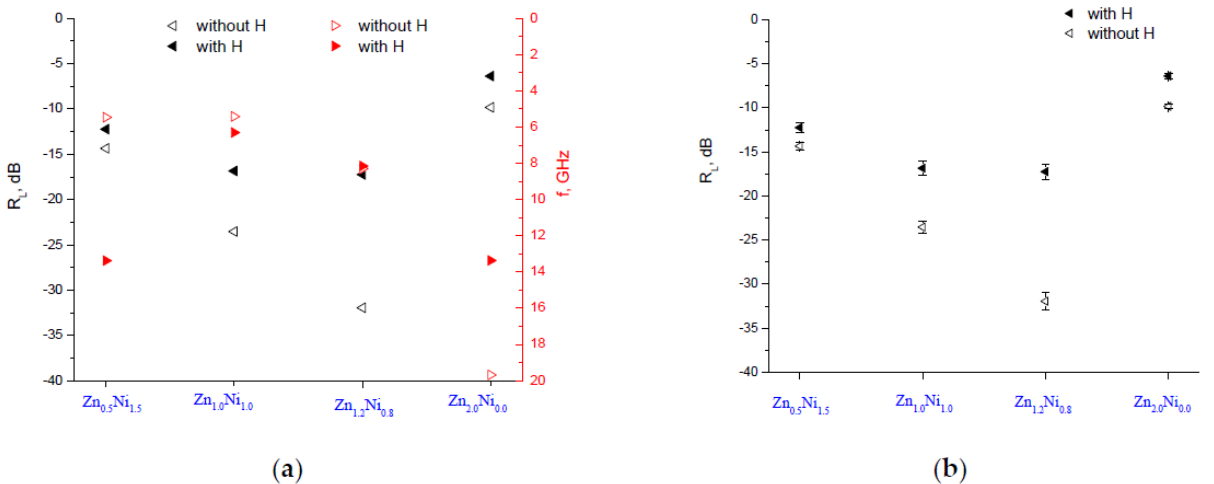
Figure 7. The main reflection loss peaks for the A series of samples depending on the Zn:Ni ratio. ( a ) Comparative view with and without a magnetic field and ( b ) an R L with a standard deviation.